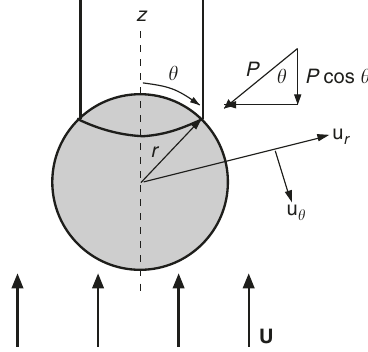
Fig. 5 Geometry of a metal diapir and trailing conduit. Diapir of radius r and trailing cylindrical conduit are symmetric about the central axis ( Z ). The uniform fl ow fi eld surrounding the sphere during descent is U . The angle θ is the polar angle between the Z axis and r as discussed in the text and Methods. Pressure is given by P and the components of velocity in the radial and polar ( θ ) direction is given by u r and u θ